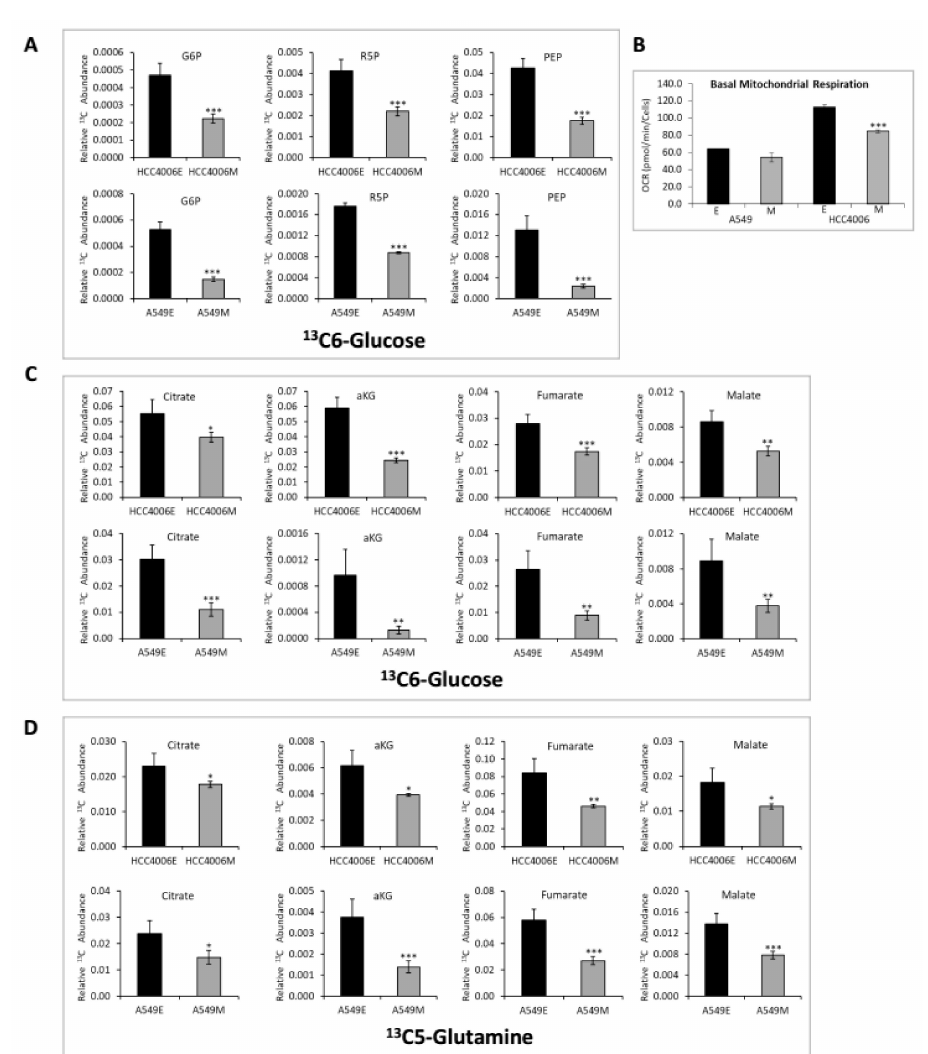
Figure 2. Reduced glycolytic and TCA cycle activity in the mesenchymal cell states. ( A ) In A549 and HCC4006 E and M state cells treated with 13C glucose, there is a decrease in glucose labeled glycolytic and pentose phosphate pathway metabolites in the M state. ( p < 0.05 *; p < 0.01 **; p < 0.001 ***). ( B ) In A549 and HCC4006, basal mitochondrial respiration is reduced in M state cells. ( C ) In A549 and HCC4006 M state cells treated with 13C6-glucose, there is a decrease in glucose labeled TCA cycle metabolites. ( D ) In A549 and HCC4006 M state cells treated with 13C5-glutamine, there is a decrease in glutamine labeled TCA cycle metabolites. Isotopologue distributions for 13C6-glucose are shown in Supplementary Figure